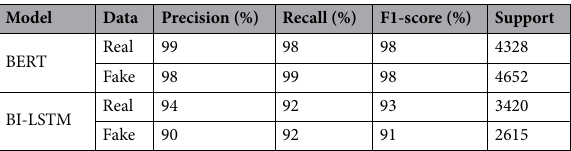
Table 1. Models’ classification results of fake news.